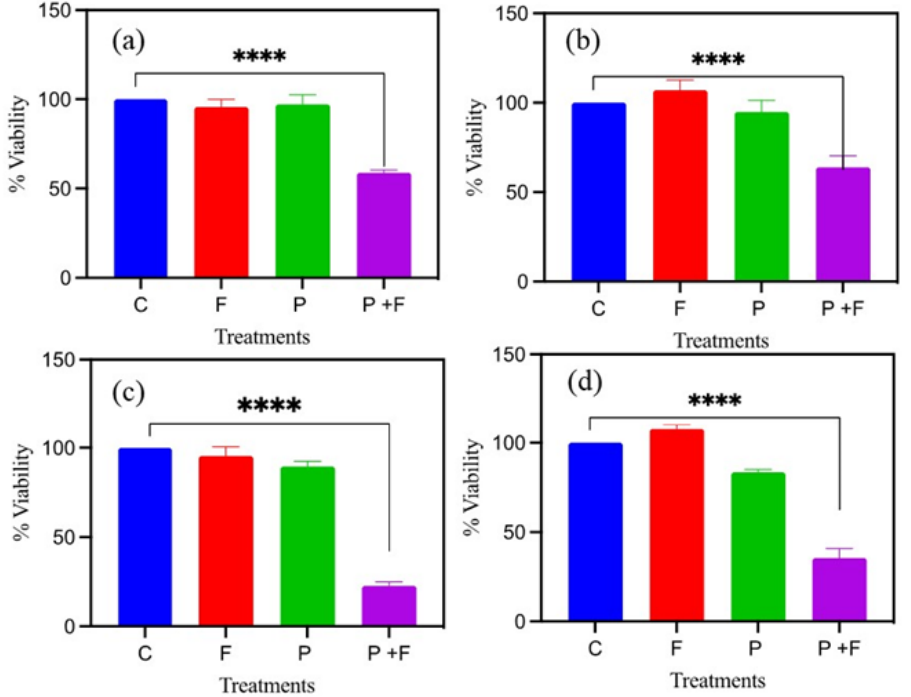
Figure 13. MTT assay after the AMF treatment; ( a ) MDA-MB-231 0 h, ( b ) HT-29 0 h, ( c ) MDA-MB-231 24 h, and ( d ) HT-29 24 h (**** indicates that P value is less than 0.0001).